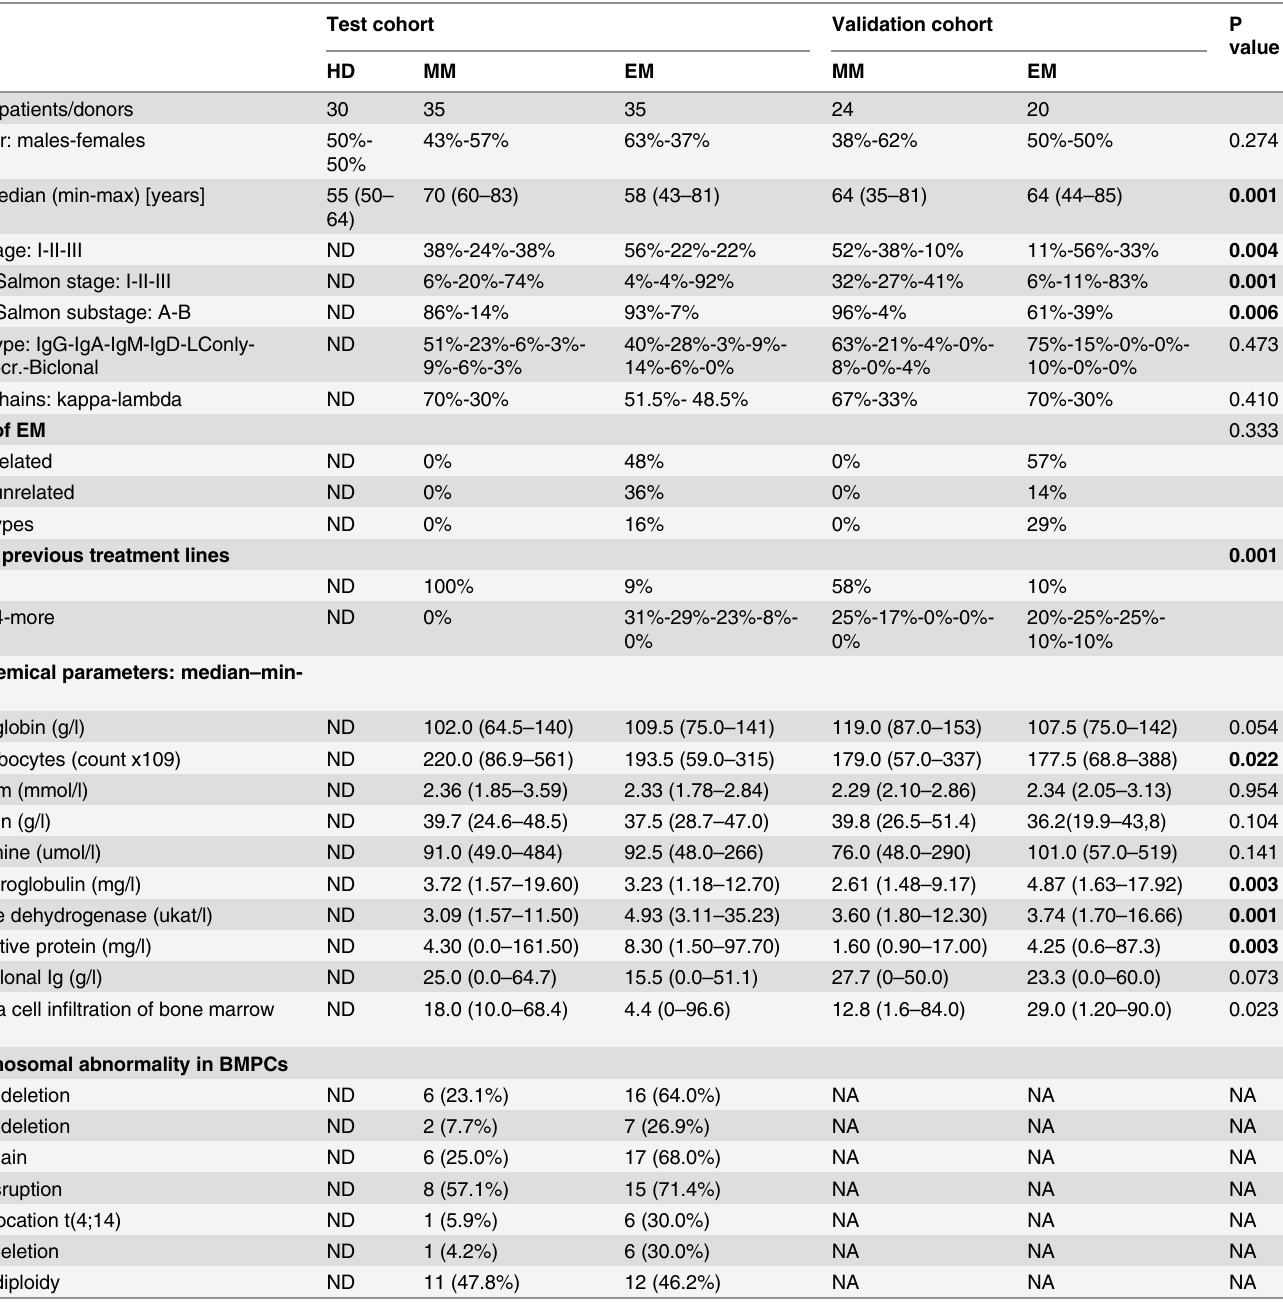
Table 1. Baseline characteristics of patients used in test and validation cohorts. Baseline characteristics of healthy donors (HD), newly diagnosed mul- tiple myeloma (MM) patients and patients with extramedullary myeloma (EM) used in a test and validation phase of the study. P values show differences in clinical parameters between studied groups, significant differences are marked in